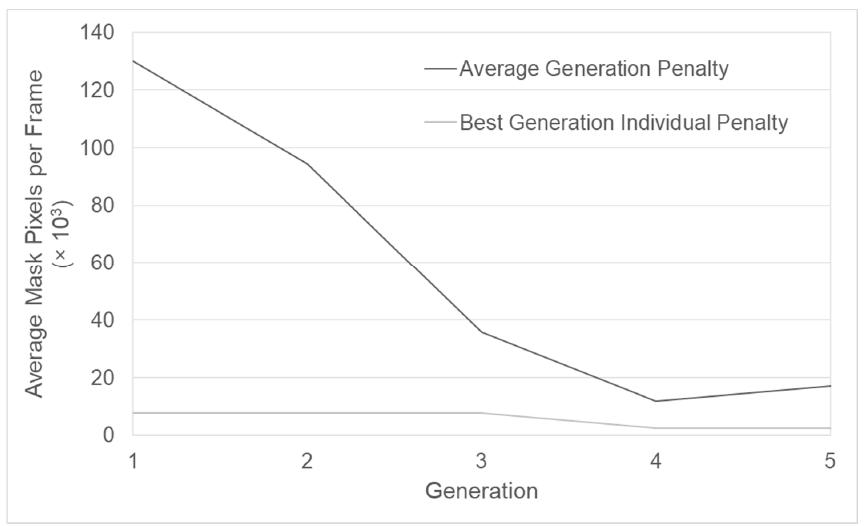
Figure 5. Evolution of the mean and average penalty per generation along a run of 5 iterations, using a penalty function of the average mask pixel count per frame.